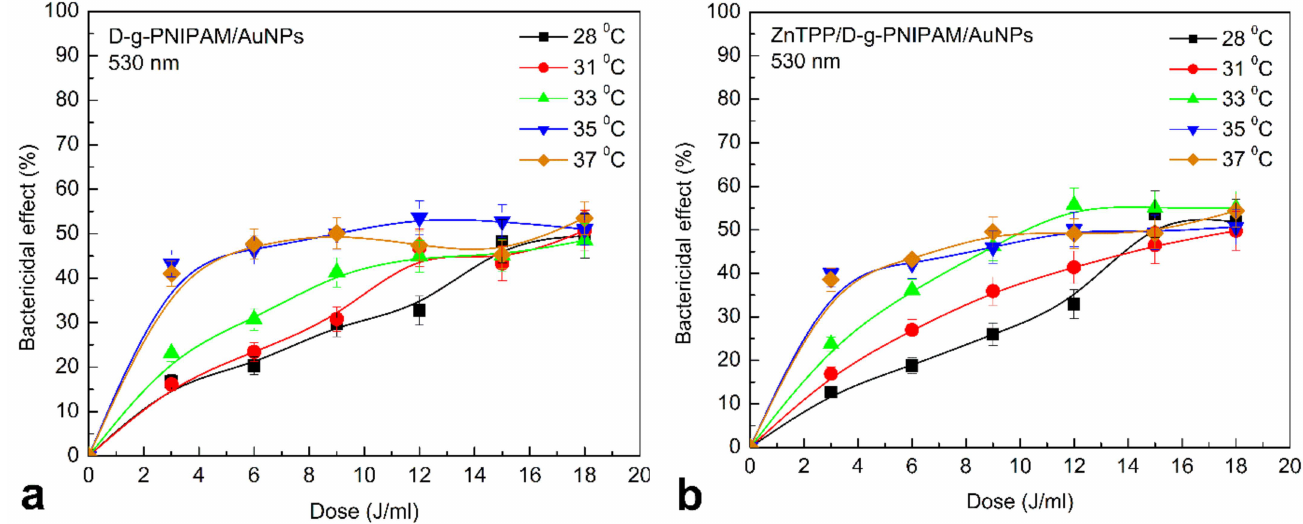
Figure 11. S. aureus inactivation at 28, 31, 33, 35, 37 ◦ C after adding of ZnTPP/D-g-PNIPAM ( a ), ZnTPP/D-g-PNIPAM/AuNPs ( b ), and irradiation by light at 420 nm depending on the ir- radiation dose. Concentrations: AuNPs and D-g-PNIPAM—0.08 g/L, 0.008 g/L, 0.0008 g/L, ZnTPP—0.001 g/L. Power of light—0.1 J/s, dose of irradiation was in the range of 3–18 J/mL with 3 J/mL increment.